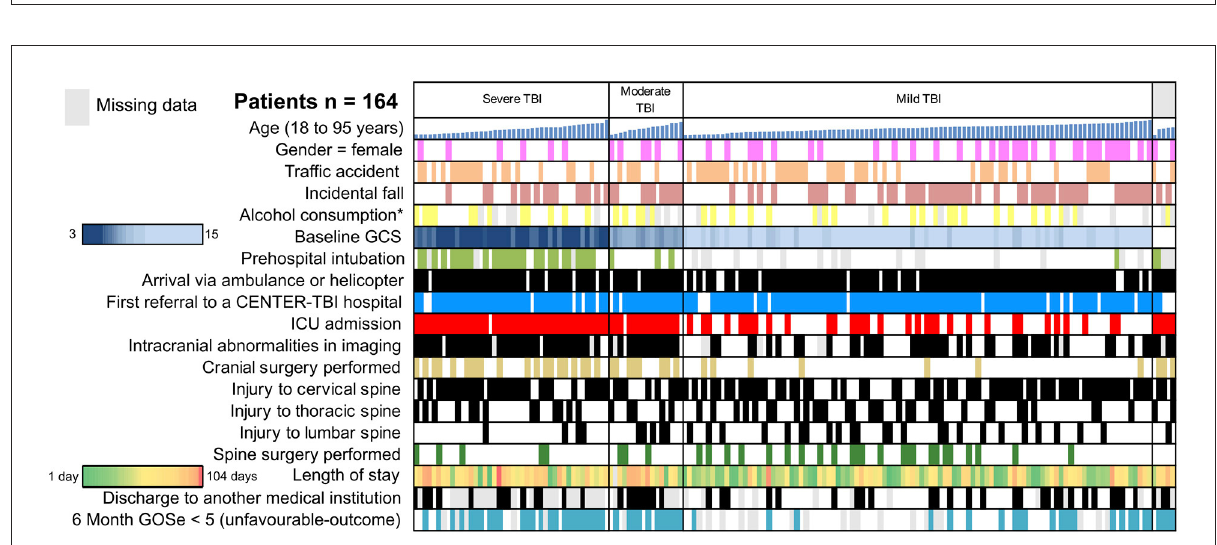
FIGURE2 Traumatic brain injury (TBI)-traumatic spine injury (TSI) study cohort. Selected variables of the 164 patients included in the analysis are depicted. Rows represent representative variables, and each column represents one patient. Sub-cohorts are separated based on TBI severity (severe TBI: GCS < 8; moderate TBI: GCS 9–12; and mild TBI: GCS 13–15). In the sub-cohorts, patients are sorted by age from youngest (19 years) to oldest (95 years). A heat-map was utilized to visualize the length of stay (green: short, red: long) and GCS (dark blue: 15, light blue: 3). ICU, intensive care unit; GOSe, Glasgow Outcome Scale Extended. *Confirmed or suspected alcohol consumption. Gray represents missing data.